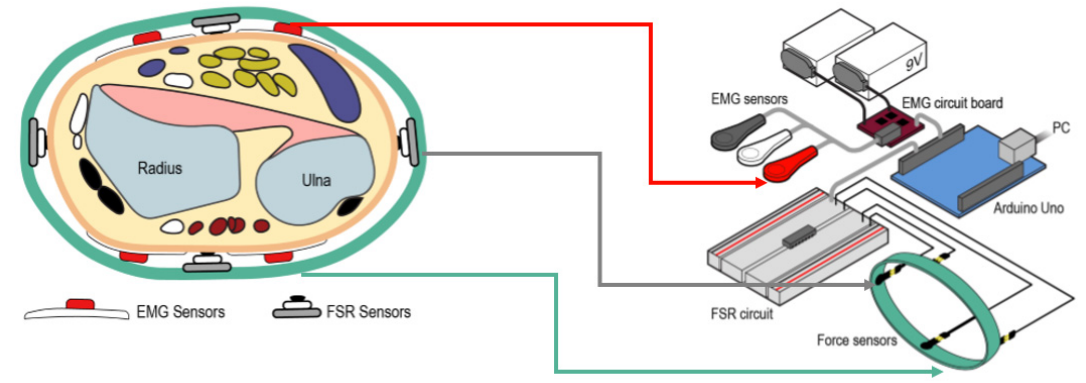
Figure 9. EMG-FSR fusion strategy and hardware diagram used to classify different hand gestures, adopted from [27] .